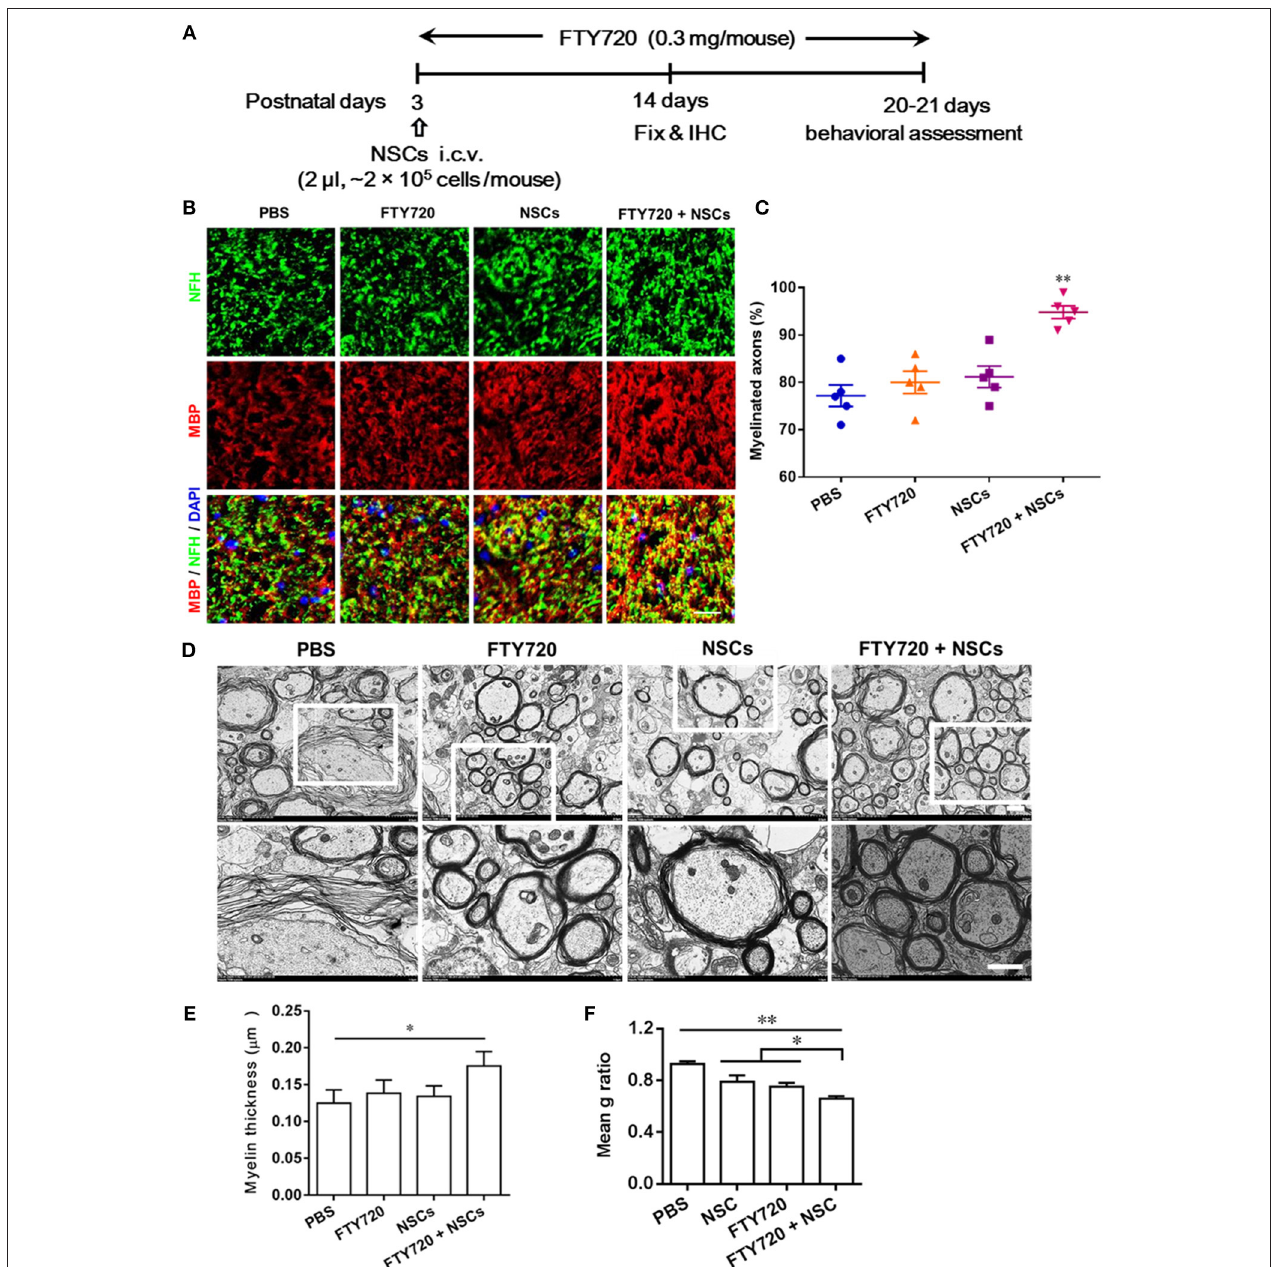
FIGURE 3 | Co-treatment with FTY720 and NSCs promoted myelination in the CNS of newborn mice in vivo . (A) Schematic diagram illustrating experimental design followed throughout this study. Mice were i.c.v. injected with NSCs (2 µ l, ∼ 2 × 10 5 cells/mouse) at day 3 postnatal, then injected daily with FTY720 i.p. (0.3 mg/mouse) or with PBS from day 3 postnatal. Spinal cords were harvested at day 14 postnatal, and stained with antibodies to MBP for myelin and to NFH for axonal fibers. (B) Representative confocal images displaying NFH (green) and MBP (red) immunoreactivity. Scale bar = 10 µ m. (C) Quantification of myelinated axons from the total number of axons in 5 mouse litters each group, performed within 5 random standard 500 µ m 2 fields in the white matter of the ventral lumbar. (D) Representative electron micrographs of transverse lumbar sections of the ventral region. Scale bar = 1.0 µ m. (E) Quantification of the mean thickness of myelin sheaths. (F) Mean g ratio (axon diameter divided by the entire myelinated fiber diameter) was determined using Image-Pro Plus software. Symbols represent mean ± SD. * p < 0.05, ** p < 0.01. One-way ANOVA with Tukey’s multiple comparisons test and unpaired Student’s t -test. so, indicating that FTY720 not only enhanced brain tissue myelination, but also promoted NSC differentiation into mature oligodendrocytes ( Figure 1D